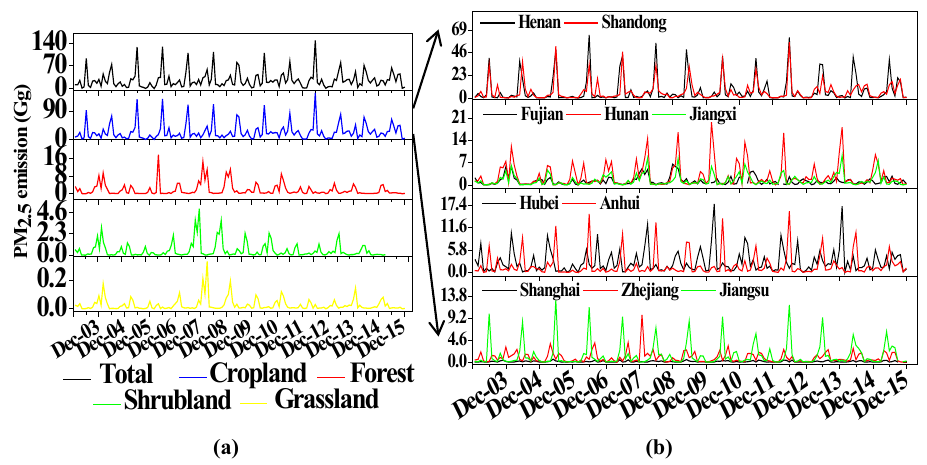
Figure 8. The monthly PM 2 . 5 emissions of different open biomass burning from 2003 to 2015 for all of central and eastern China (a) and each province (b) .